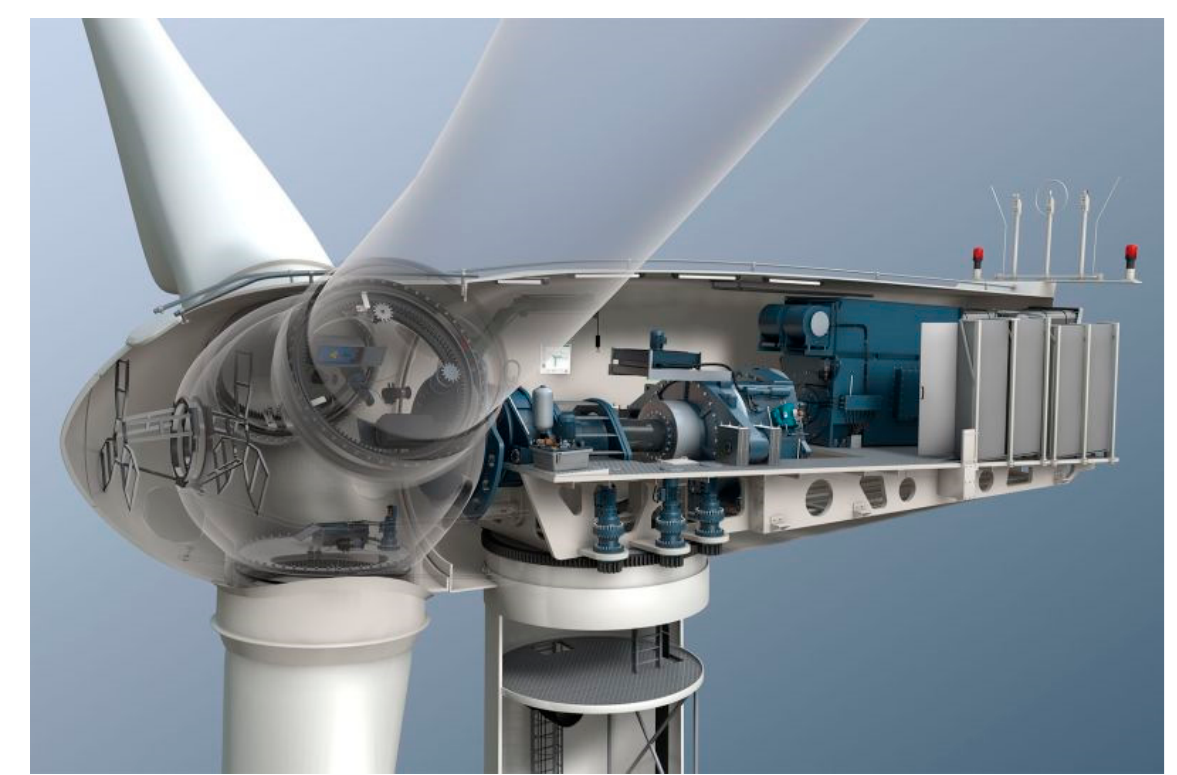
Figure 1. View of the main wind turbine modules (with permission of ifm.com) [15].